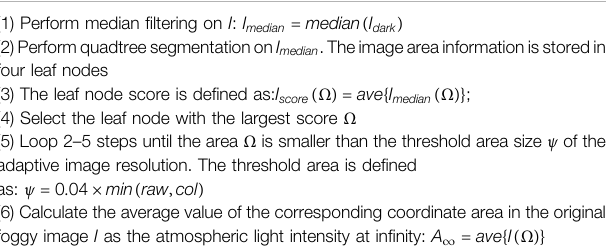
TABLE 1 | The method for estimating atmospheric light intensity at in fi